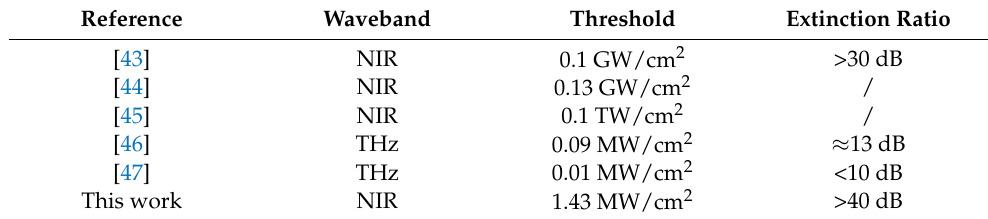
Table 1. Comparison of this work with previous works.